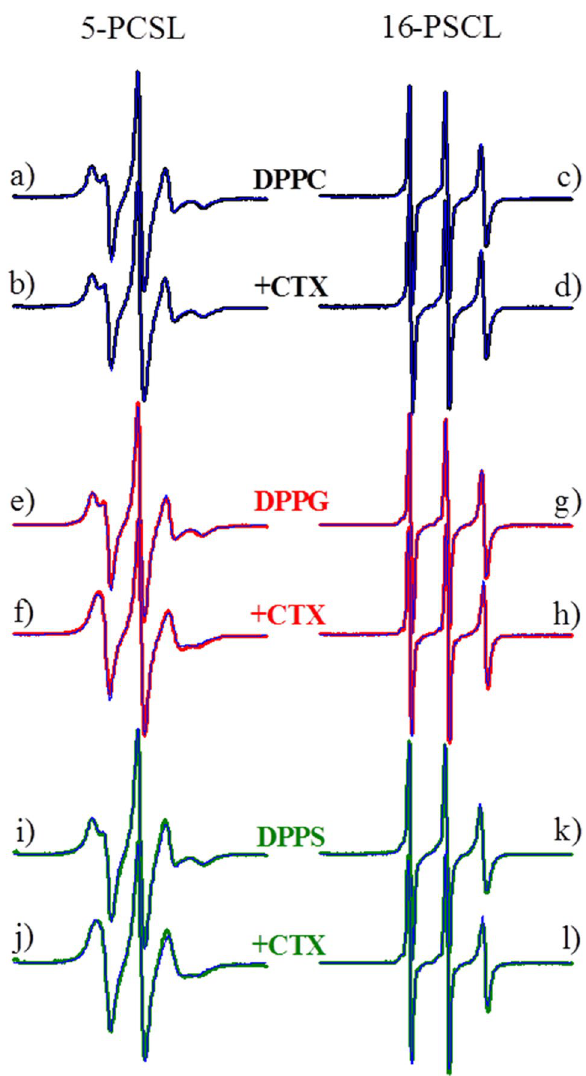
Figure 8. Typical ESR spectra of 5-PCSL and 16-PCSL spin labels incorporated into the fluid phase of pure lipid bilayers of DPPC ( a , c , black lines), DPPG ( e , g , red lines) and DPPS ( i , k , olive lines), and the mixtures of 0.1 mol% CTX relative to the lipid concentration of DPPC ( b , d , black lines), DPPG ( f , h , red lines) and DPPS ( j , l , olive lines). The spectra were acquired at 60 °C, and its total width is 100 G. Blue lines correspond to the best fittings of the experimental spectra by the theoretical simulations (see